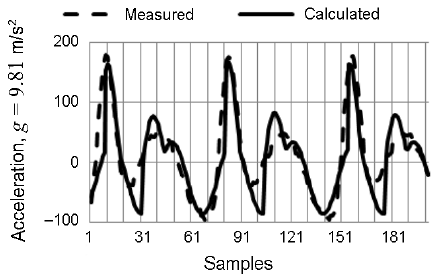
Fig. 10. Comparison of the measured accelerations during ins- tallation with the ones obtained via the mathematical modelling